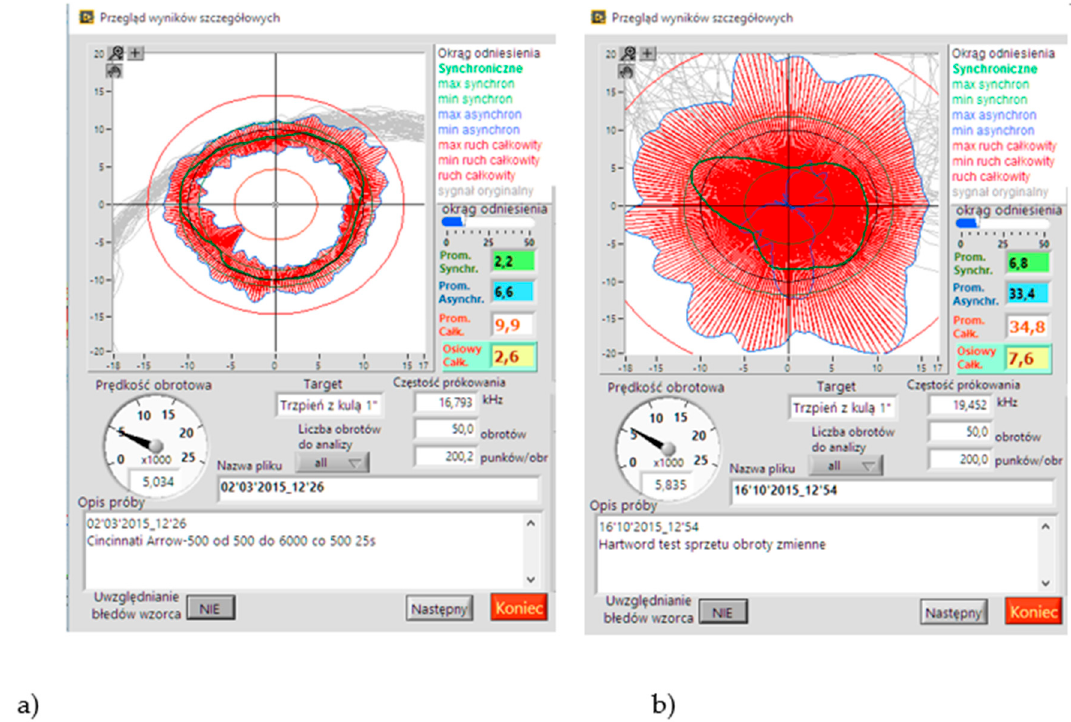
Figure 72. Polar diagrams for the spindle rotational speed of 5000 min − 1 : ( a ) a machine tool working sporadically and ( b ) used